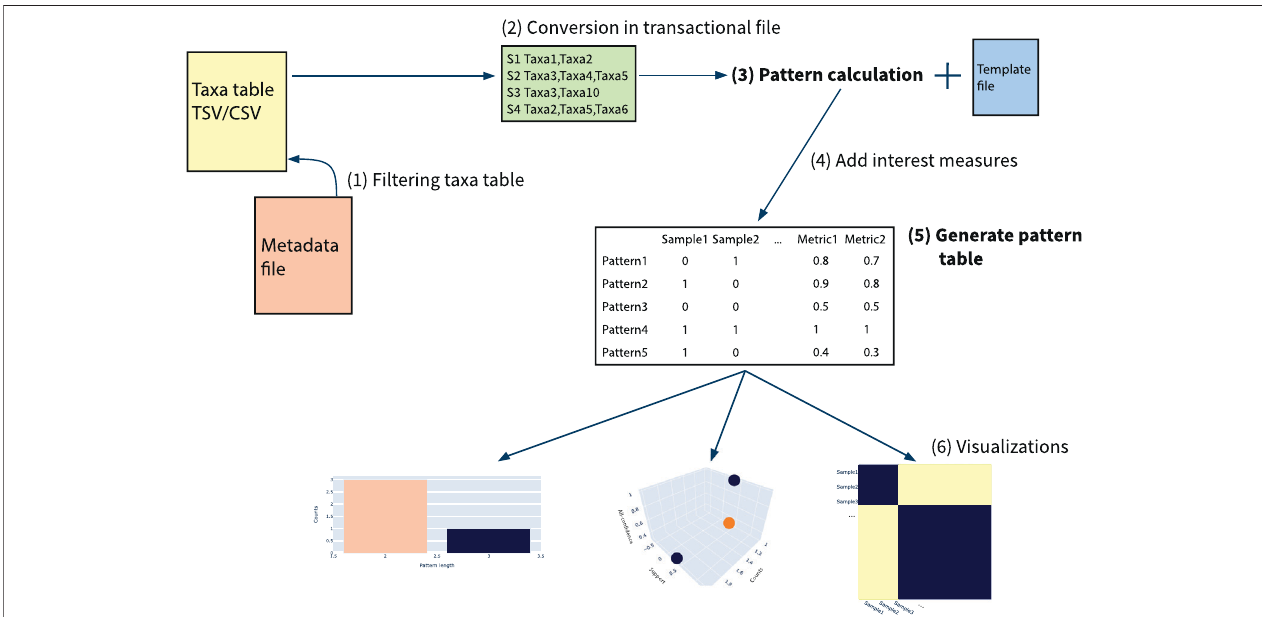
FIGURE 2| Scheme of microFIM framework. 1) Filtering taxa table; 2) Conversion of taxa tableinto transactional fi le; 3) Extract patternswith template fi le fi lled with minimumsupportthreshold,minimumandmaximumlength;4)Addingofinterestmeasuresassupport,patternlengthandall-con fi dence(Omiecinski,2003;Xiongetal., 2006); 5) Generating pattern table, composed by presence-absence of patterns within samples and interest measures; 6) Generating